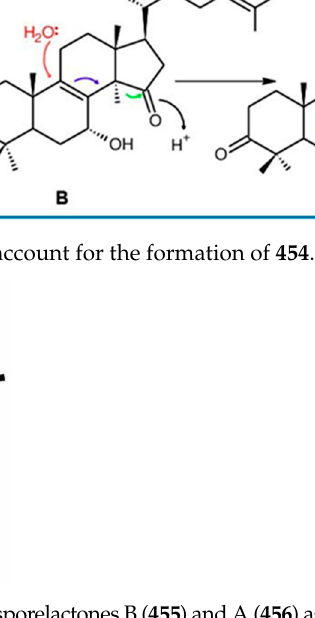
Figure 21. Chemical structures of ganosporelactones B ( 455 ) and A ( 456 ) as rearranged novel triterpenoids.